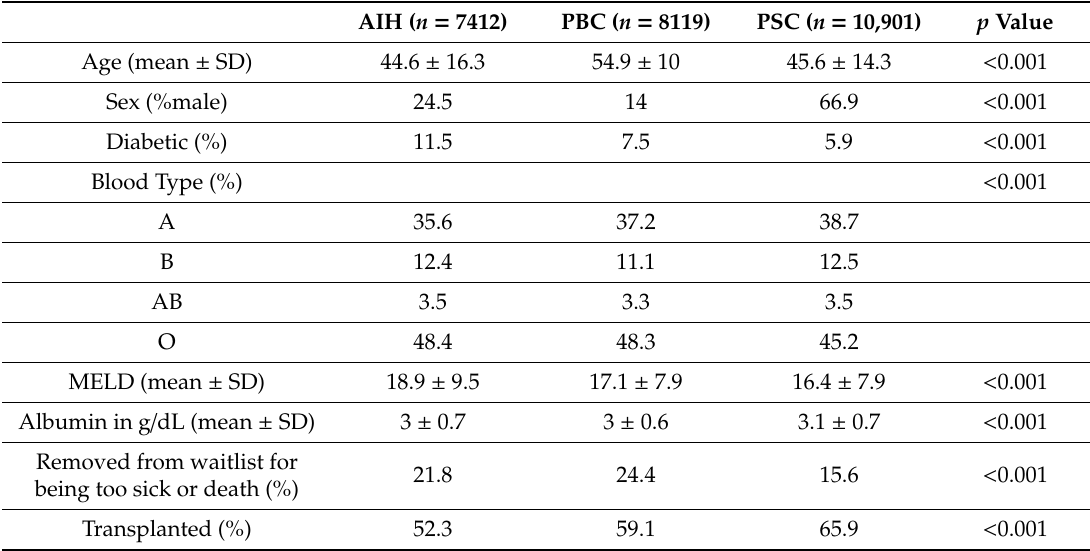
Table 2. Cause of death while on liver transplant waitlist by etiology. AIH: autoimmune hepatitis; PBC: primary biliary cholangitis; PSC: primary sclerosing cholangitis. AIH( n = 1115) PBC( n = 1424) PSC( n = 1108) Died on waitlist (%)